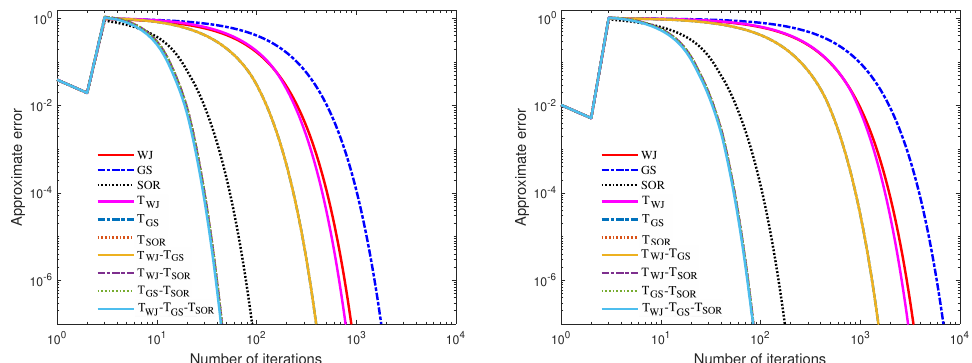
Figure 1. Relative error of the GS, WJ, and SOR methods and all cases of the proposed methods in solving the problem (16) with l = 50 and l = 100, respectively.